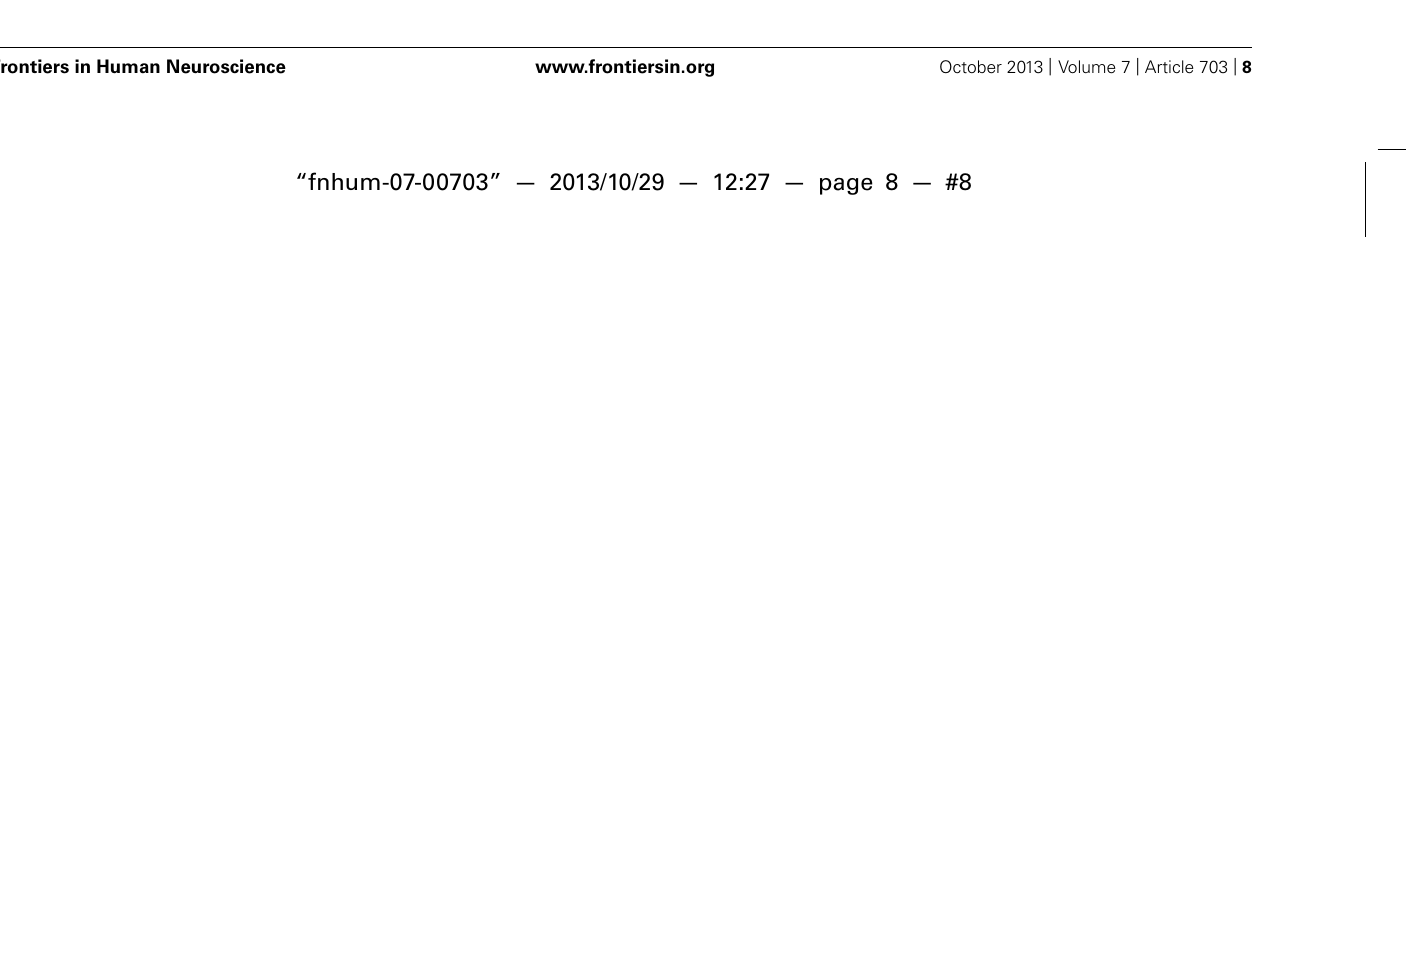
the Naming task, the cartographies were made on a 40-ms time-window centered on vocal onset (from − 20 to 20 ms after vocal onset) and a 100 ms-long baseline was taken between 200 and 100 ms before vocal